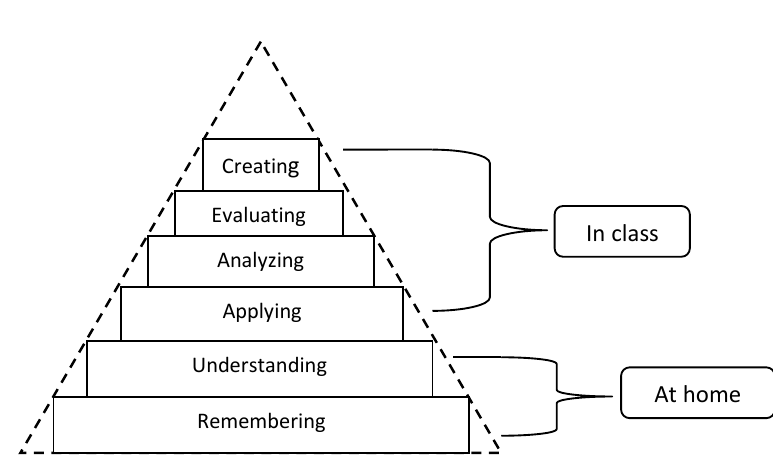
Figure 1 . Bloom’s revised taxonomy in the flipped classroom With the flipped model, the lower levels are presented before class through recorded lectures and video. Readings, simulations, and other materials also provide this foundational support for learning so that in-class time can be spent working on higher levels of learning from application to evaluation. In flipped classrooms, students go from the lowest level (remembering) to achieve the highest level (creating). Lankford (2013) mentioned that the flipped classroom focuses on how to support the learners in achieving a higher level of the taxonomy domain. Additionally, Nederveld and Berge (2015) added that in flipped learning, classroom activity is spent on application and higher-level of learning rather than listening to lectures and other lower-level thinking tasks. As shown in Table 1, implementing flipped learning allows the students to spend more time supporting higher-level learning tasks such as a group discussion, while lower-level tasks such as knowledge and comprehension are completed independently outside the class.